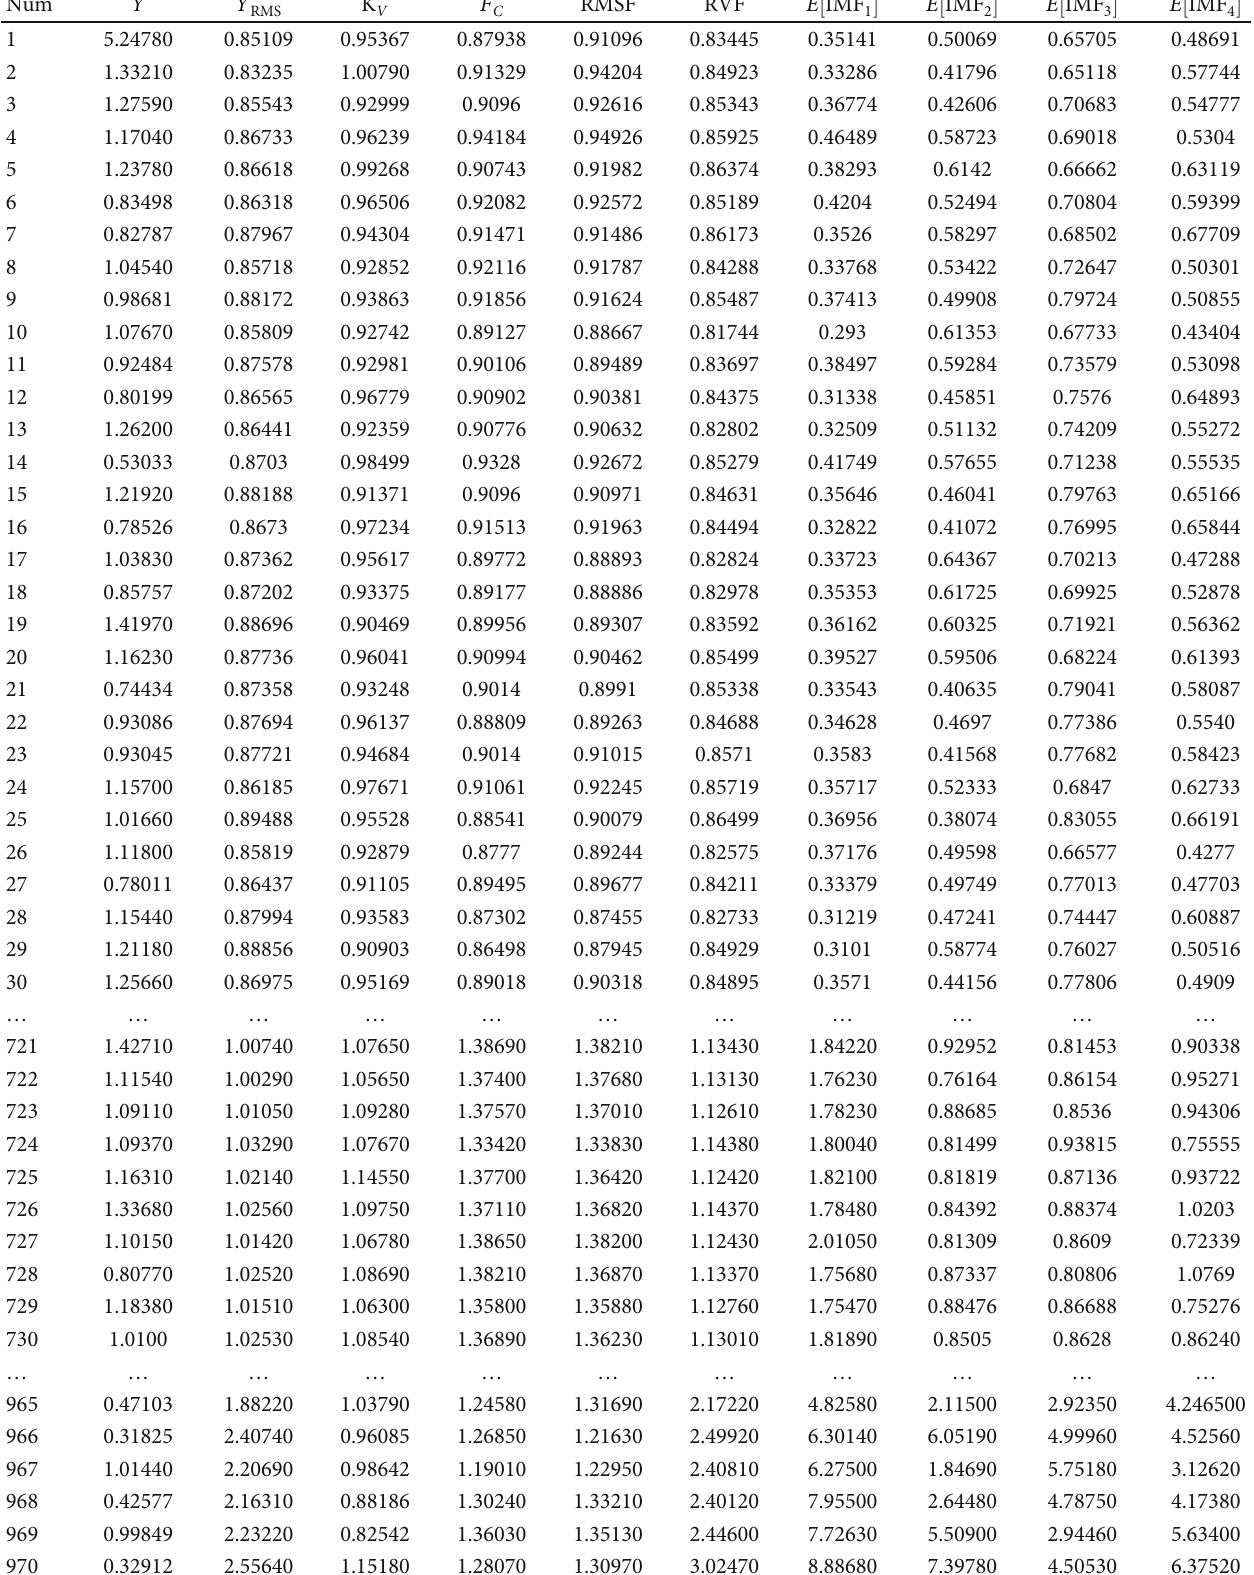
Table 3: Normalized feature parameter matrix of roller vibration signal of fl exible material R2R